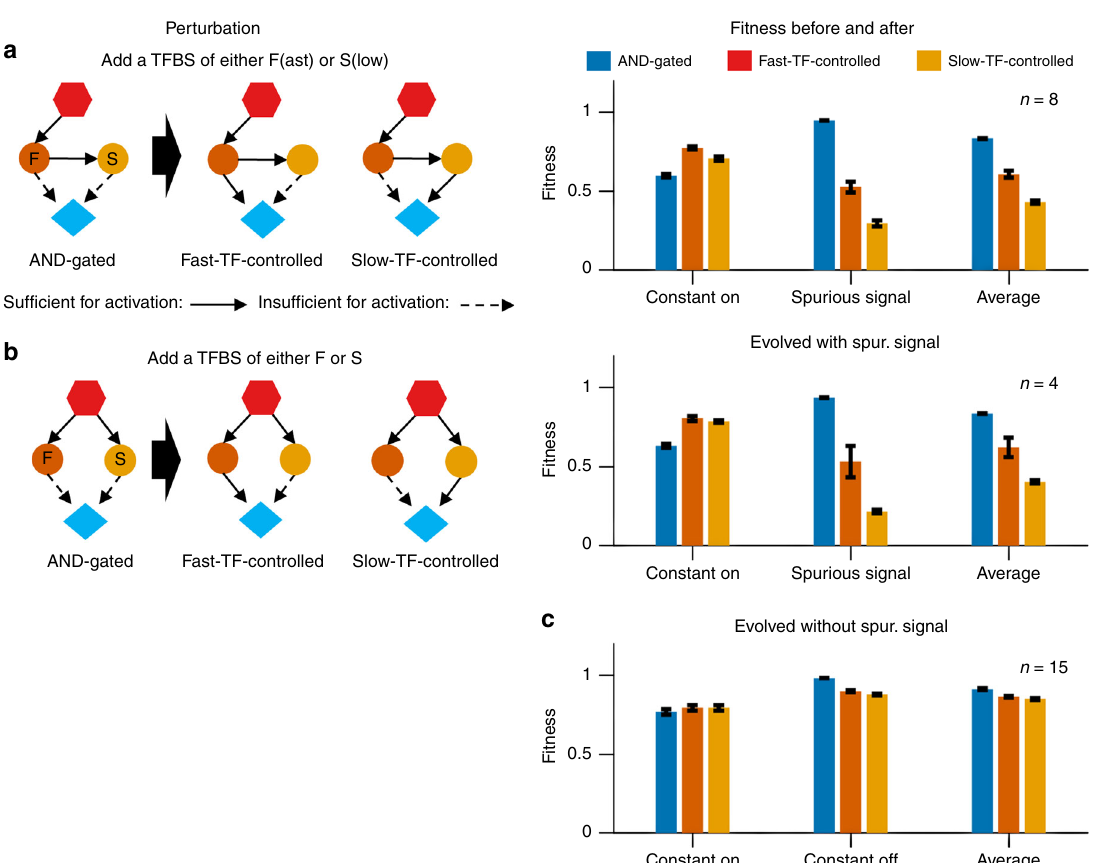
Fig. 9 Isolated C1-FFLs and diamonds rely on AND gates to fi lter out short spurious signals. We add a TFBS of either the fast TF or the slow TF to break the AND gate. This slightly increases the ability to respond to the signal, but leads to a larger loss of fi tness when effector expression is undesirable. We perform the perturbation on a 8 of the 18 high- fi tness replicates from Fig. 7b that evolved an AND-gated C1-FFL, b 4 of the 26 high- fi tness replicates that evolved an AND-gated diamond in Fig. 7b, and c 15 of the 37 replicates that evolved an AND-gated diamond in response to selection for signal recognition in the absence of an external spurious signal (Fig. 10b). Replicate exclusion was based on the co-occurrence of other motifs with the potential to confound results (see Supplementary Methods for details). Fitness is shown as mean ± s.e.m. of over replicate evolutionary simulations, calculated as described for